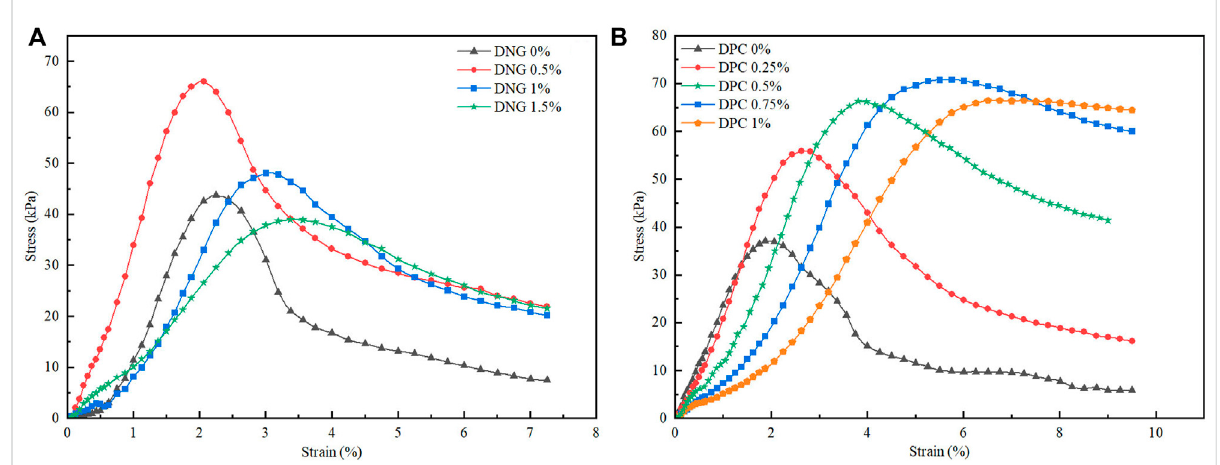
FIGURE 6 Stress – strain curves of mixed sample of PPE and silty sand at different concentrations. (A) – Mixed sample of DNG and silty sand; (B) – Mixed sample of DPC and silty